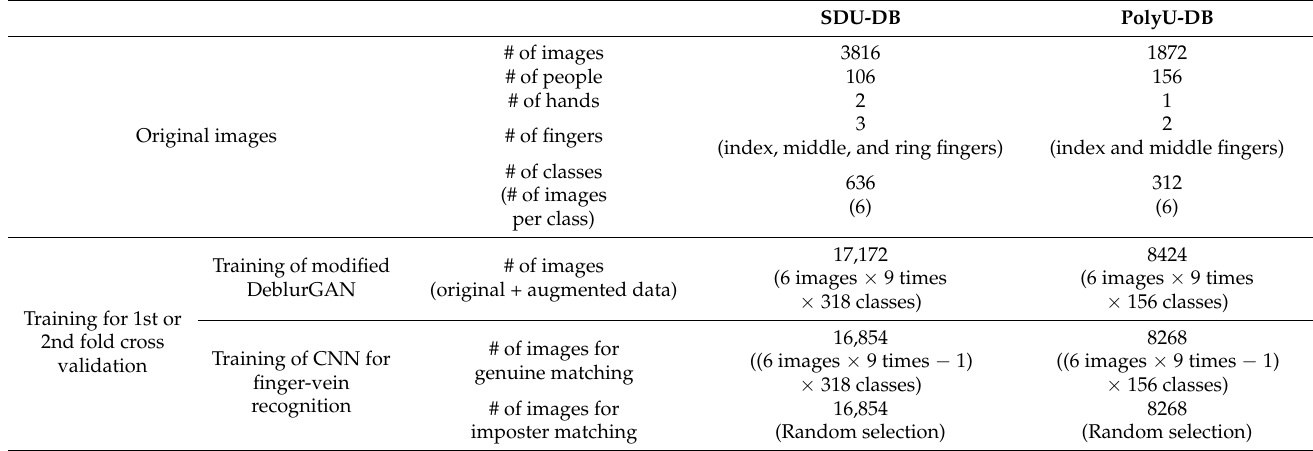
Table 4. Descriptions of experimental databases by data